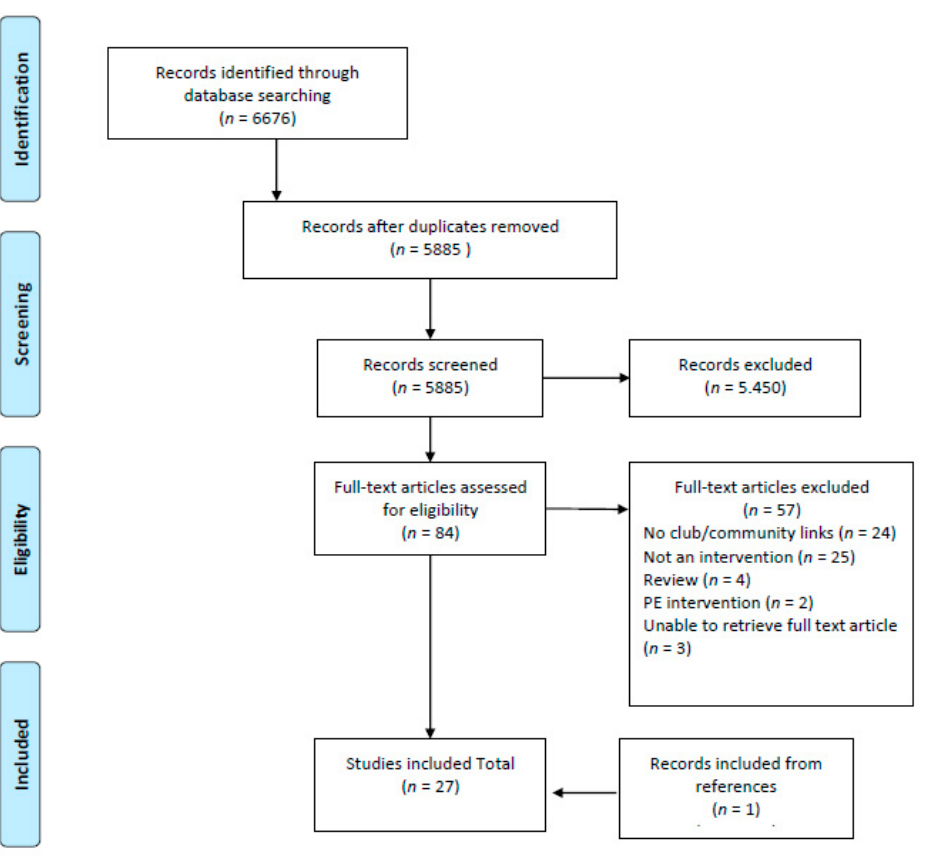
Figure 1. Flowchart of the screening process.